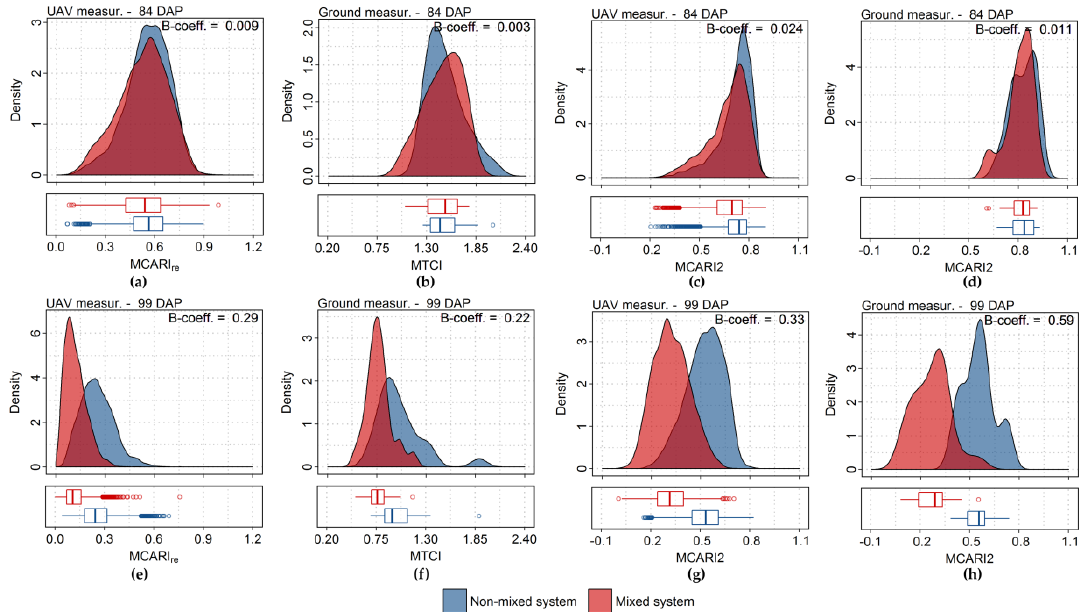
Figure 13. Distribution of MCARI re (Modified Chlorophyll Absorption Ratio Index Red Edge, Table 2), MTCI (MERIS terrestrial chlorophyll index, Table 2), and MCARI2 calculated from UAV ( a , c , e , g ) and ground-based data ( b , d , f , h ), respectively. Estimate probability density and boxplot corresponding to observations from a given sensor and acquisition date are presented for each treatment (i.e., non-mixed and mixed systems). Results concerning UAV and ground data correspond, respectively, to approximately 10,800 pixels and to 48 spectral measurements, per acquisition date.